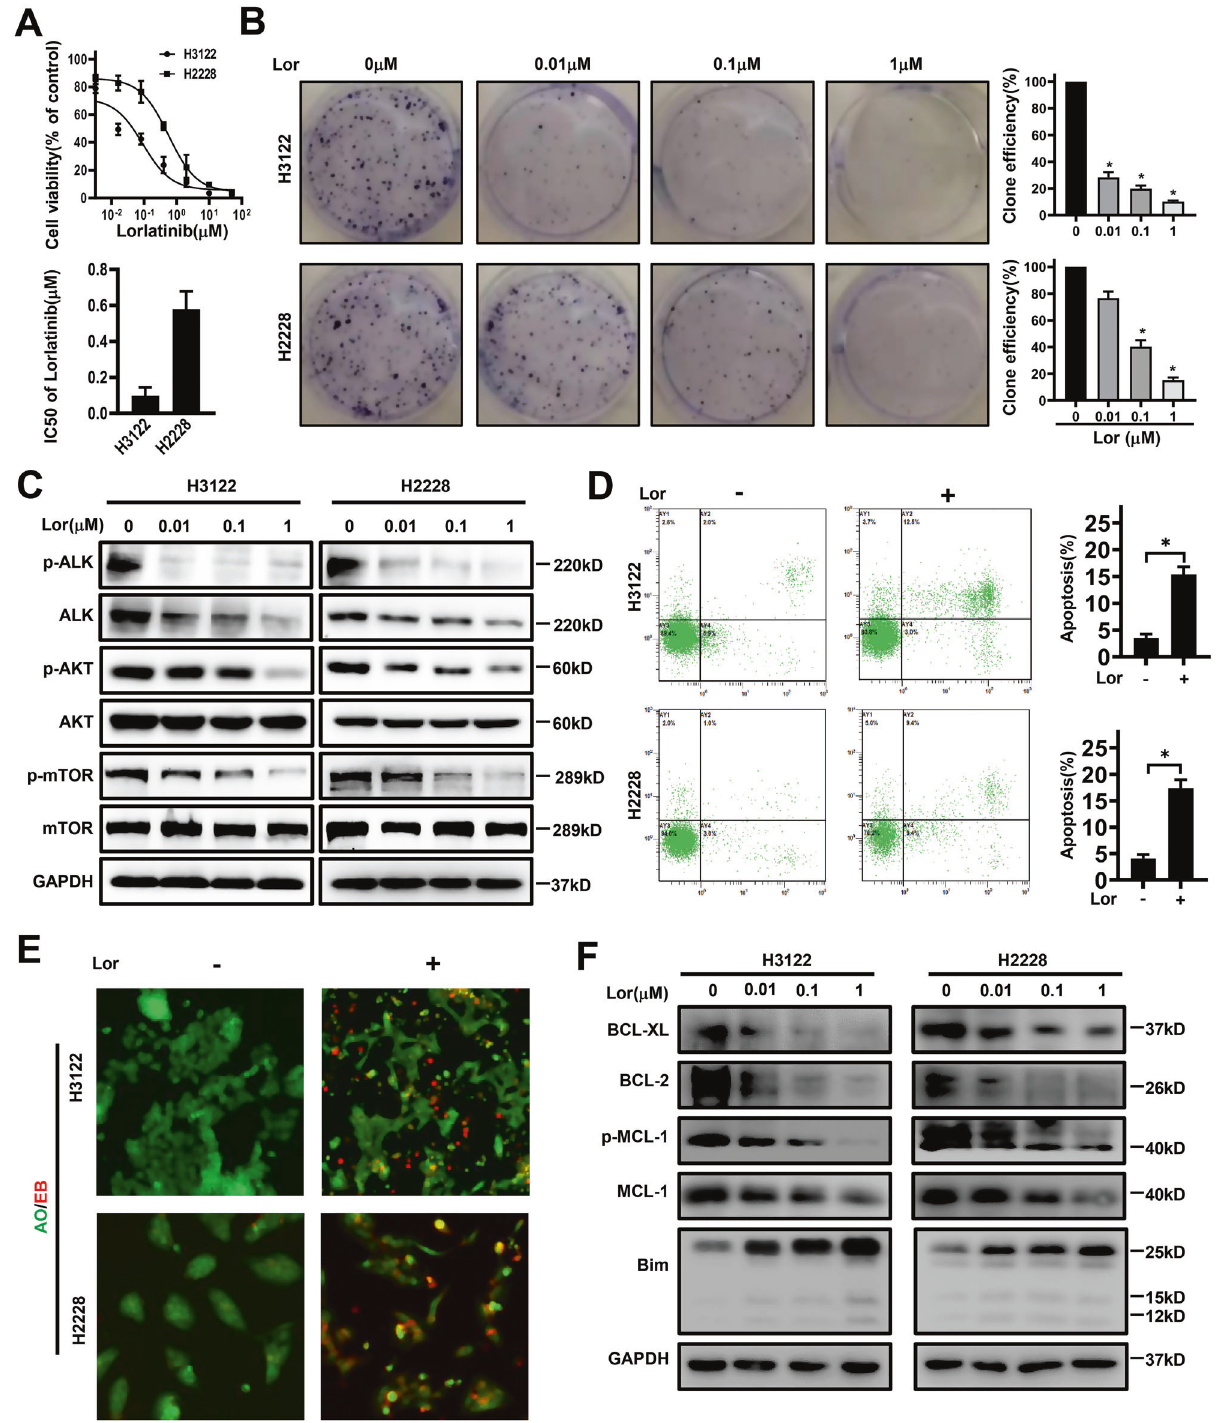
Fig. 1 Lorlatinib reduces the viability of lung cancer cells. A CCK-8 assay using H3122 and H2228 cells treated with the indicated concentrations of lorlatinib for 48 h. B Colony-formation assay in cells treated with various concentrations of lorlatinib. C Western blot showed the expression of phosphorylation/total ALK, AKT, and mTOR in lorlatinib-treated H3122 and H2228 cells. D Cells were treated with lorlatinib (10 nM). The ratio of apoptotic cells was measured by Annexin V-FITC and propidium iodide (PI) staining. E AO/EB staining analyzed lorlatinib- induced apoptosis. F Cells were treated with the indicated concentrations of lorlatinib for 48 h. And after that, western blot analysis was performed on the Bim, BCL-2, MCL-1, P-MCL-1, and BCL-XL expression levels. Cells indicated that experiments were performed in triplicates and the results are shown as mean ± S.E.M. Lor lorlatinib. * P < 0.01 compared with control.